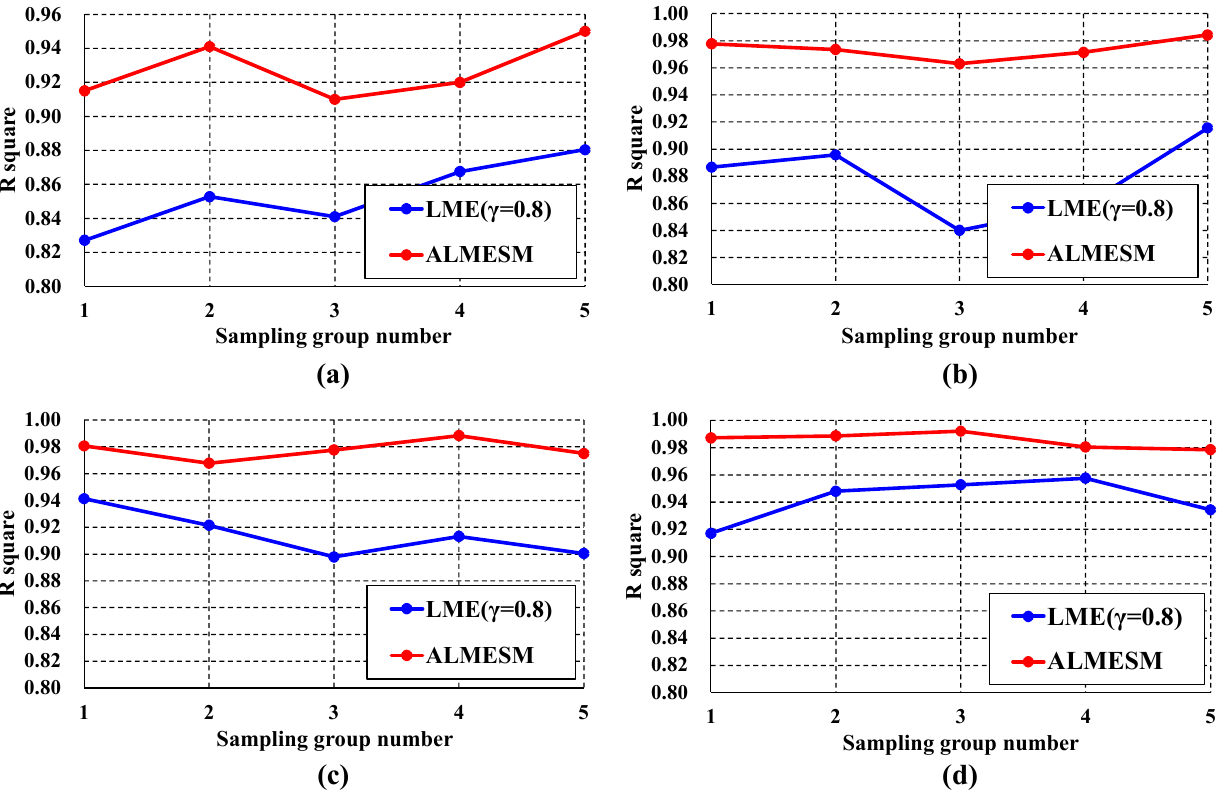
Figure 4. Dispersion analysis of 5 CVT samplings of the original LME approximation and ALMESM.